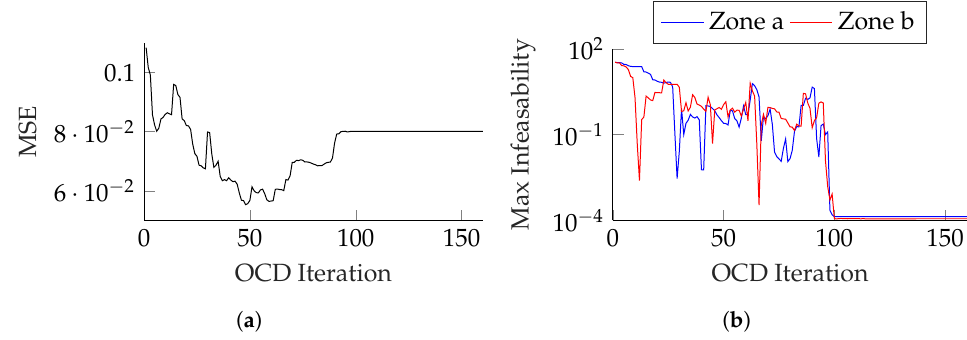
Figure 6. Eight-node network with the marginal bid price c e Hydraulic Pre-Calculation. ( a ) MSE as defined in (32); ( b ) Maximum infeasability per zone.